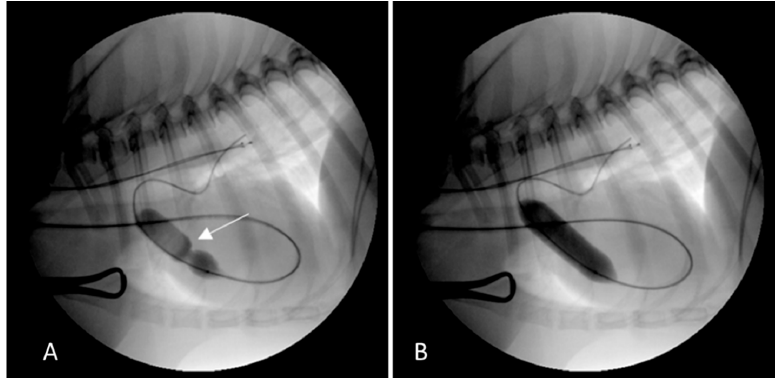
Figure 1. Fluoroscopic images of the pulmonary balloon valvuloplasty in Case 1 performed using vascular access through the left external jugular vein access. ( A ) The balloon was partially inflated across the pulmonary valve stenosis. The stenosis was identified by the waist, which was seen as the balloon was inflated (white arrow). The guidewire passed into the cranial vena cava, through the right atrium and the right ventricle, and out into the pulmonary artery. ( B ) The balloon was completely inflated causing the waist to abruptly resolve.